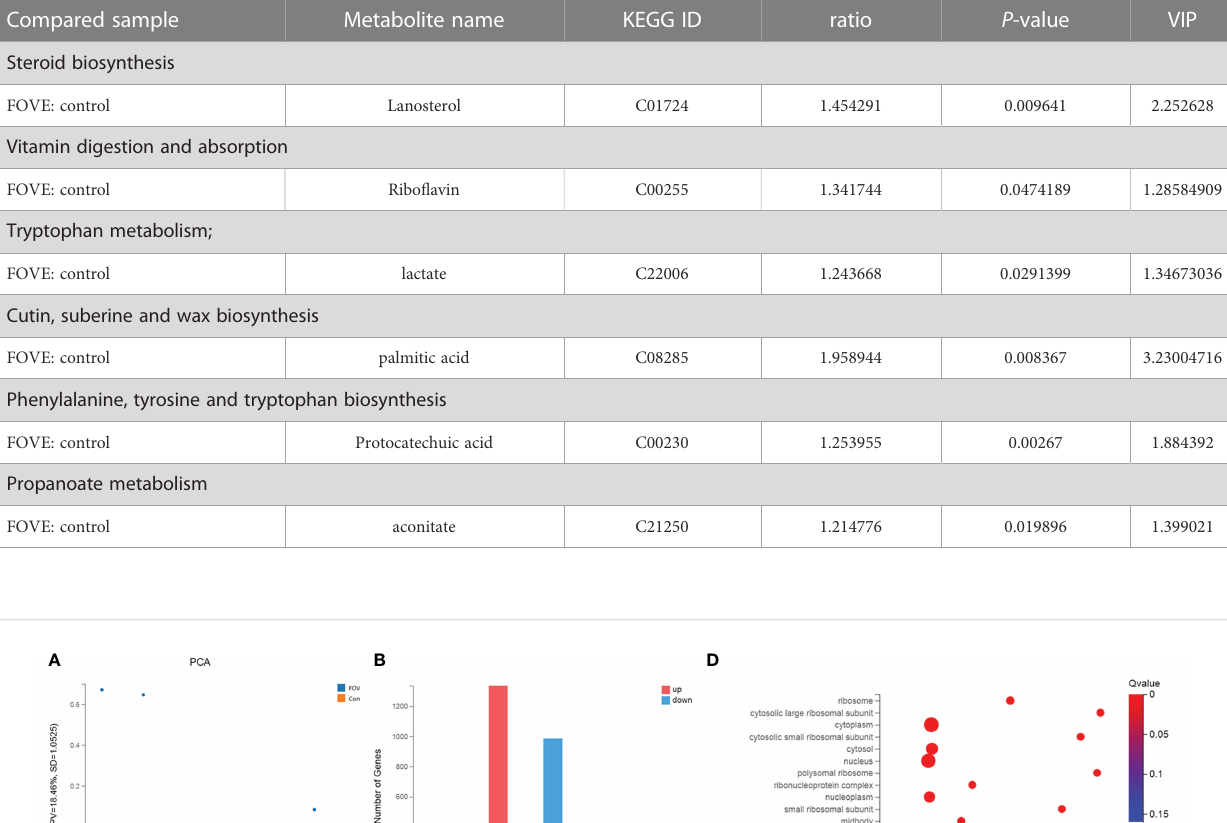
TABLE 5 Changes in the main metabolites between the control and FOVE groups.